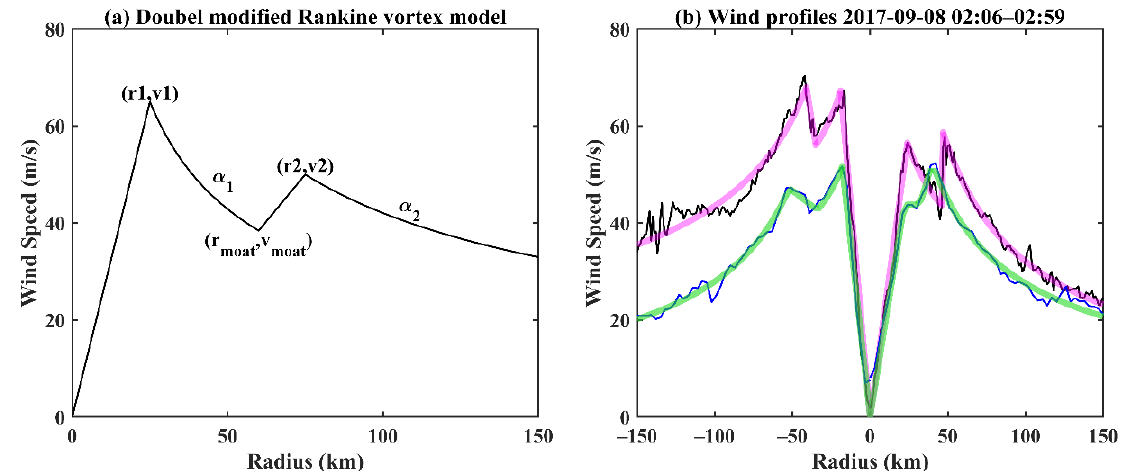
Figure 2. ( a ) DRV model visualization labeled with the corresponding eight parameters. ( b ) An example of wind profiles at the free-atmosphere level (black solid line) and the sea-surface level (blue solid line) with the corresponding parameterized fit (magenta line and green line) employing the DRV model for Hurricane Irma from 02:06 to 02:59 UTC on 8 September 2017.